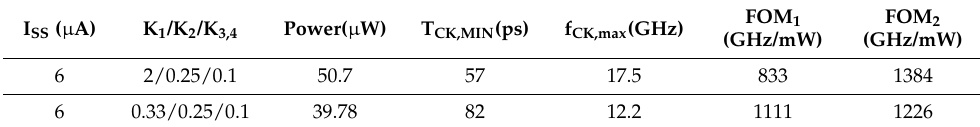
Table 5. Summary of dividers by 16 with only nType DIV2 with input level shifters (with